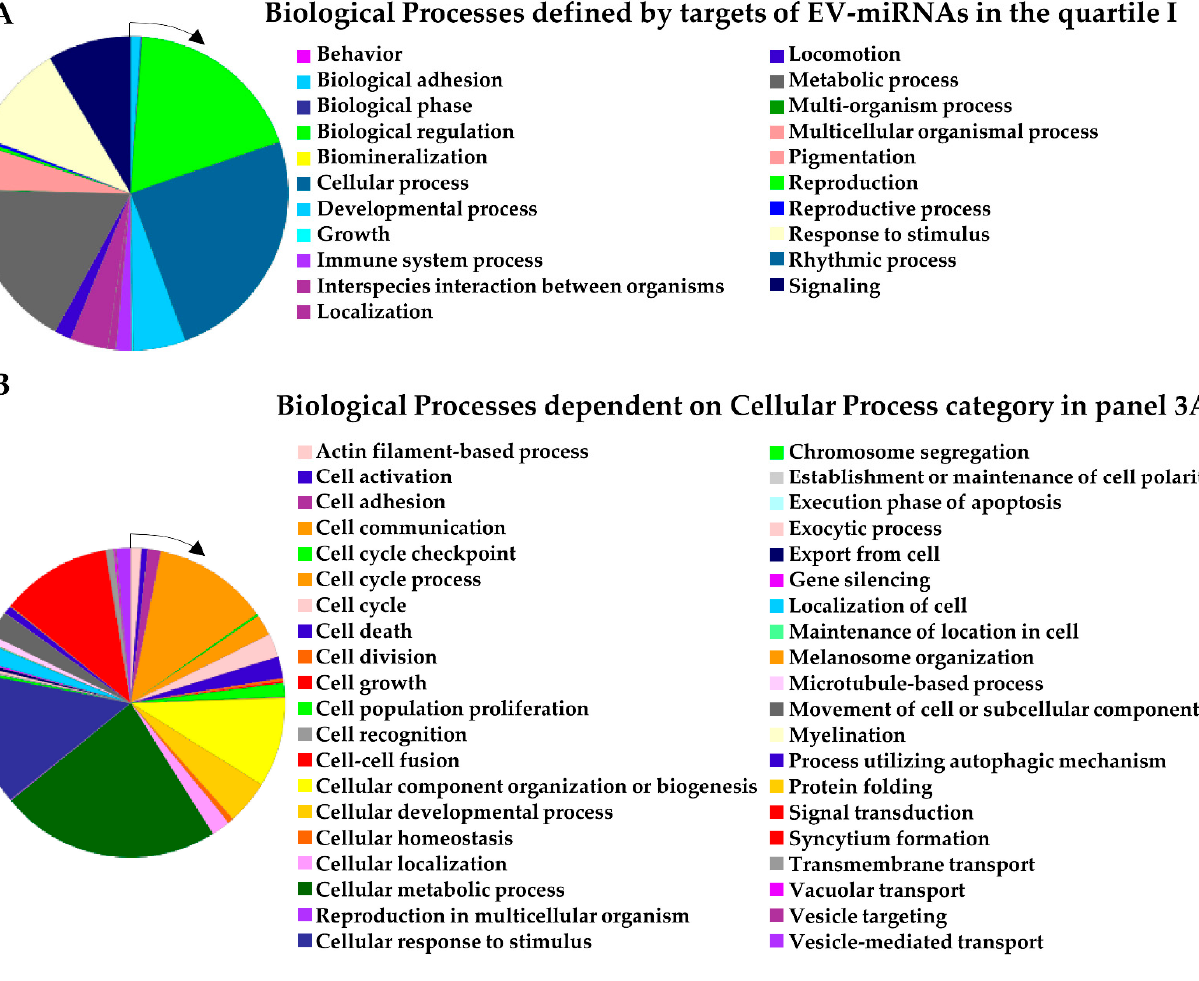
Figure 3. Biological processes (BPs) of first-quartile EV-miRNA univocal targets. ( A ) BPs defined by 1364 univocal targets of first-quartile EV-miRNAs obtained after median C RT calculation of all conditions. ( B ) BPs defining the “cellular process” BP in panel A.